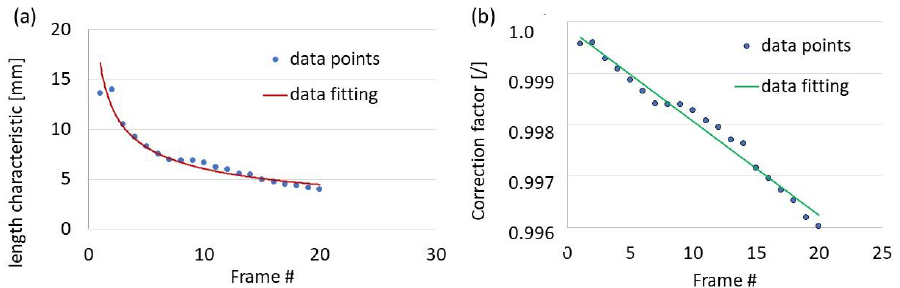
Figure 16. Correction of the true stress–strain curve calculation: ( a ) distribution of the necking length parameter characteristic for the last 20 frames of recorded tension test, ( b ) distribution of the correction factor.